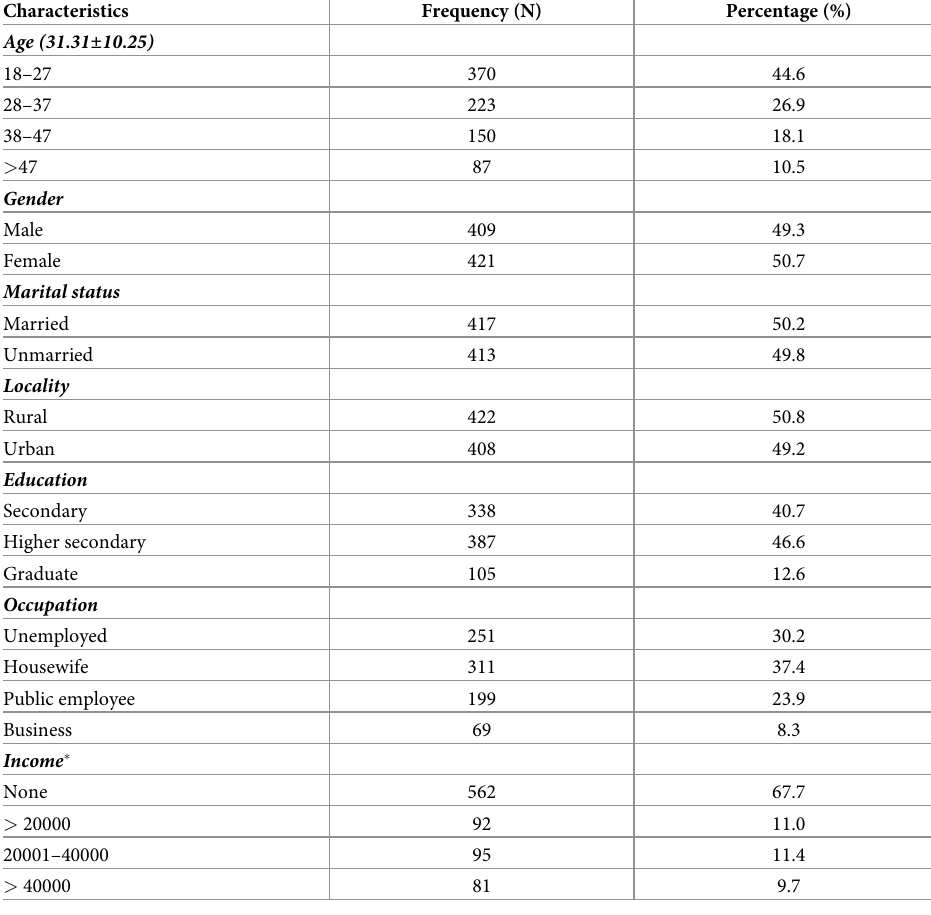
Table 1. Demographic profile of the study